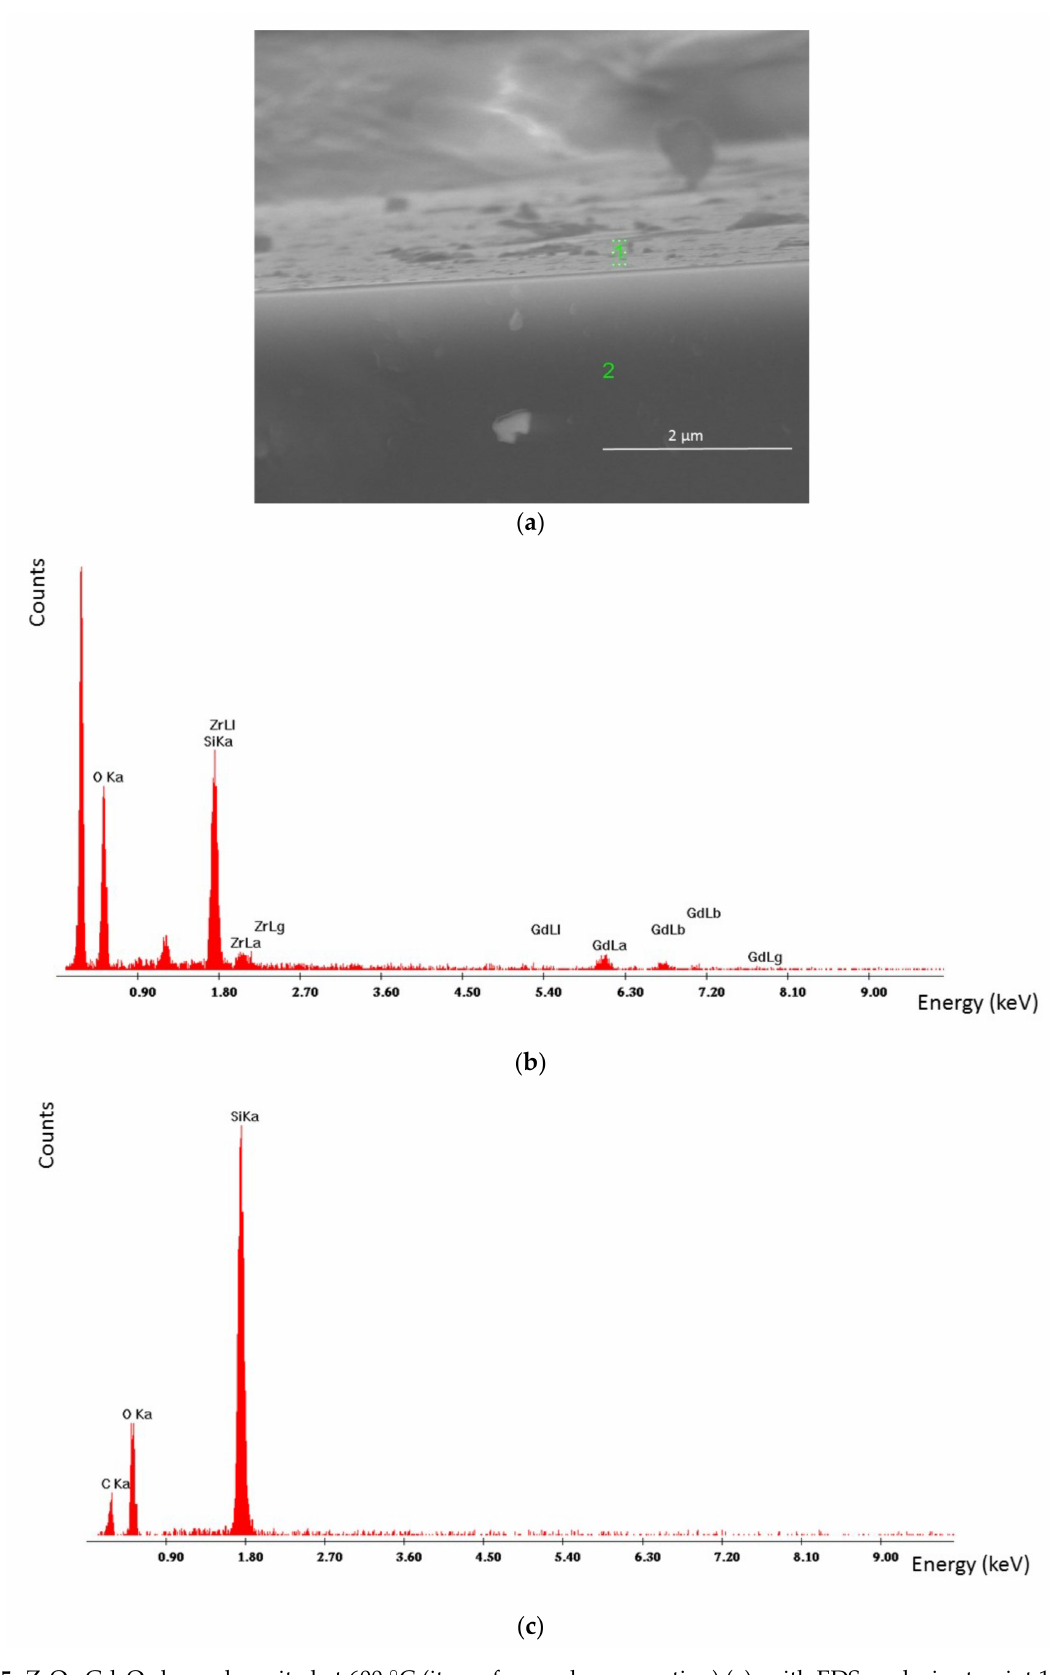
Figure 5. ZrO 2 -Gd 2 O 3 layer deposited at 600 ◦ C (its surface and cross-section) ( a ), with EDS analysis at point 1 ( b ) and point 2 ( c ). Molar content of Gd(tmhd) 3 in the gas reaction mixture: 20%. Synthesis time: 15